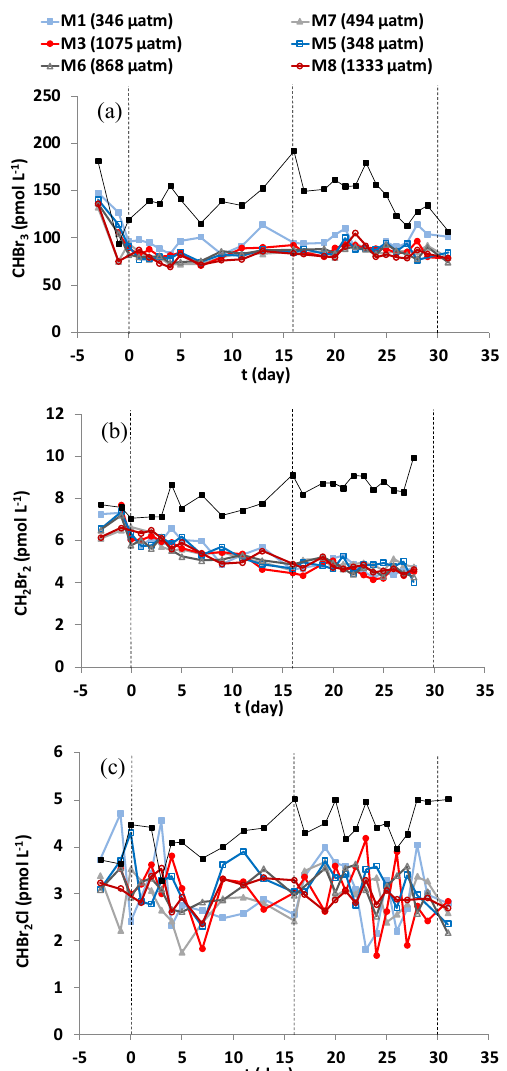
Figure 4. Mean concentrations (pmolL − 1 ) of (a) CHBr 3 , (b) CH 2 Br 2 , and (c) CHBr 2 Cl taken from a water sample integrated from the surface 10m. Dashed lines indicate the phases of the ex- periment as defined in Fig. 2; f CO 2 shown in the legend is mean f CO 2 across the duration of the